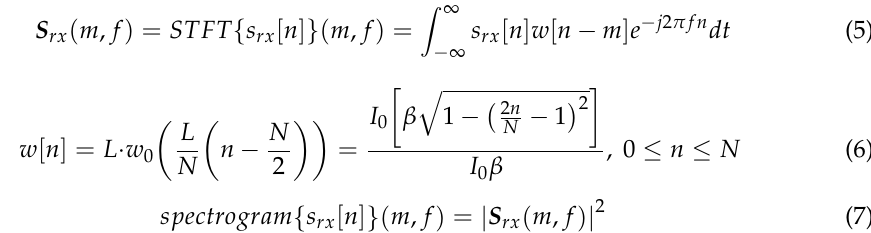
Figure 3. Band-limited bit signal on the spectrogram.